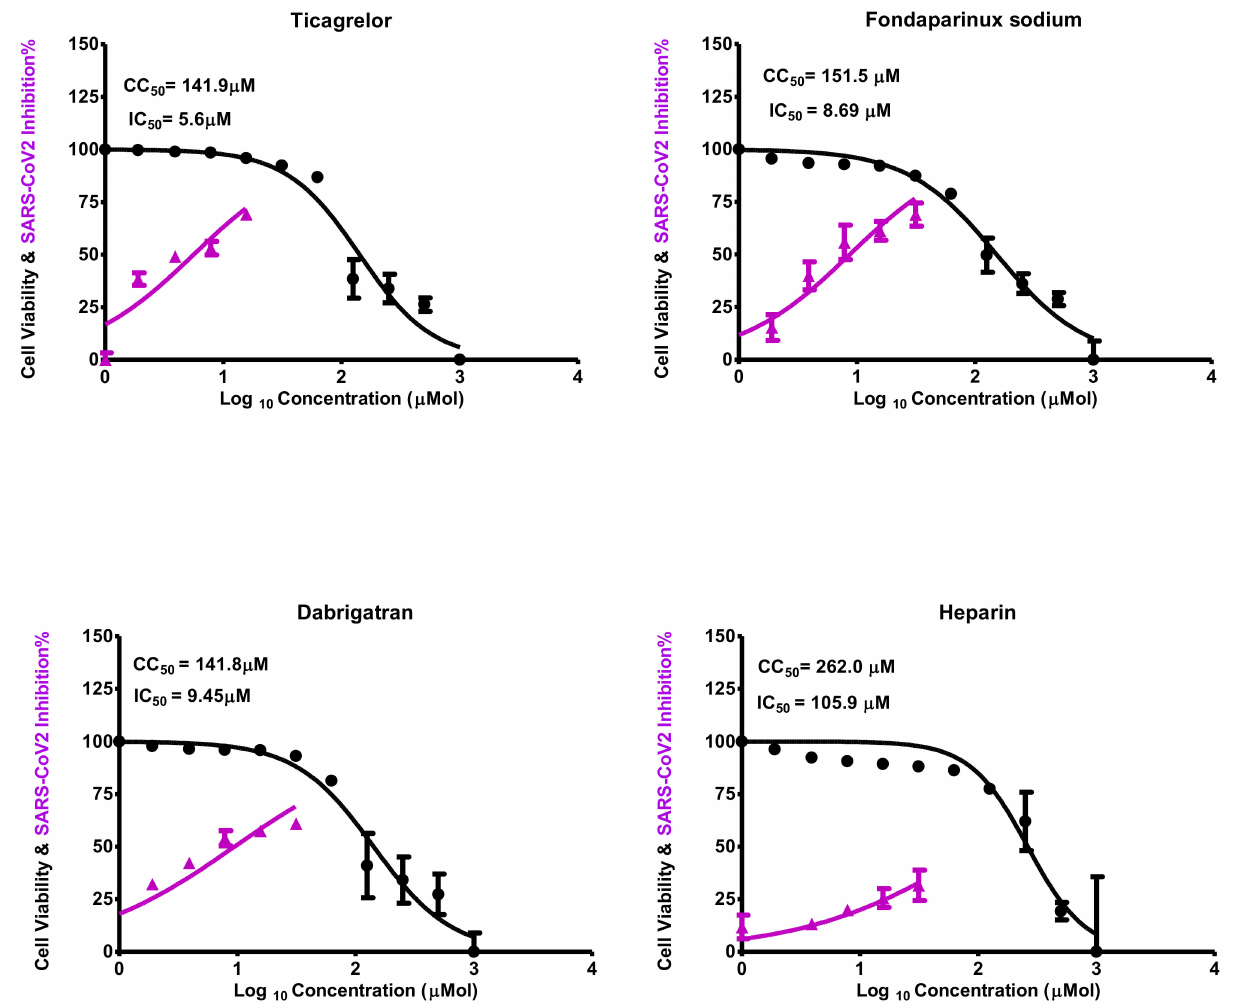
Figure 9. Cytotoxicity concentration 50 (CC 50 ) and inhibitory concentration 50 (IC 50 ) values for the screened anticoagulants (ticagrelor, fondaparinux sodium, dabigatran, and heparin), revealing their intrinsic activity against SARS-CoV-2. IC 50 was calculated by the best line drawn between log concentration and viral inhibition % (triplicate for each concentration) by GraphPad Prism 5 software shown under the figure of CC 50 and IC 50